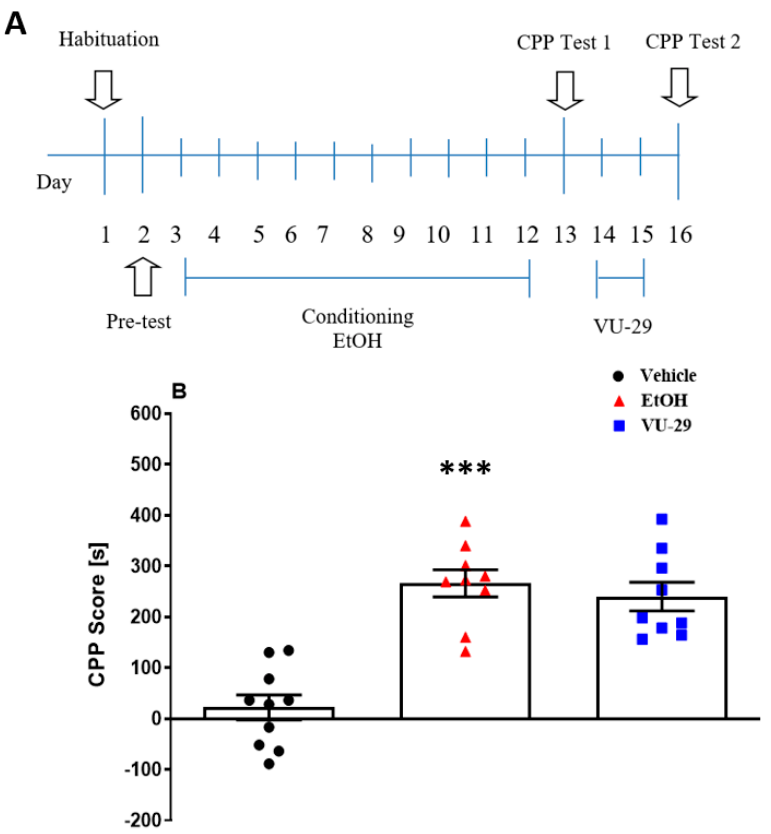
Figure 1. Experimental design for the e ff ect of VU-29 on short-time maintenance of ethanol-induced CPP ( A ). Data are shown as post-conditioning minus pre-conditioning time (s) spent in the drug-associated compartment in the CPP Test 2 ( B ). Dots represent individual measurements, the central horizontal mark is the mean, and error bars represent SEM. *** p < 0.001 vs. vehicle. Table 1. The e ff ect of 2 days VU-29 administration to ethanol-conditioned rats on locomotor activity measured as the number of crossings from one compartment to another during 15 min of Test 2. Results are expressed as mean ± SEM. Group Number of Crossings (15 min) P Value